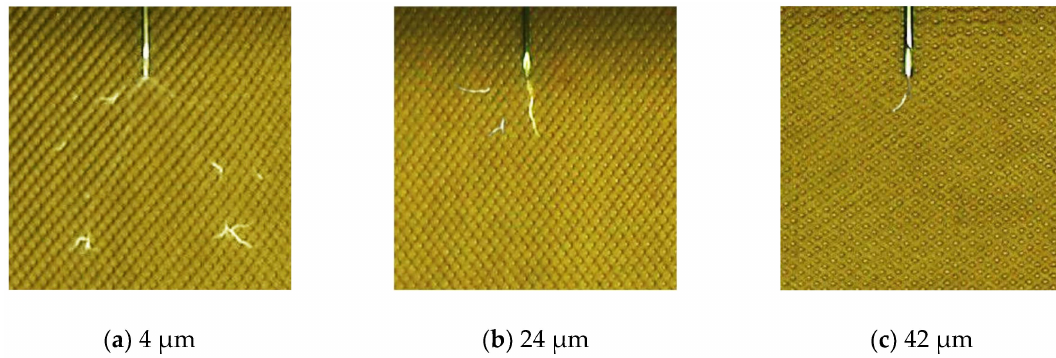
Figure 9. Various forms of the spark discharge at 62 kV under different curvatures.